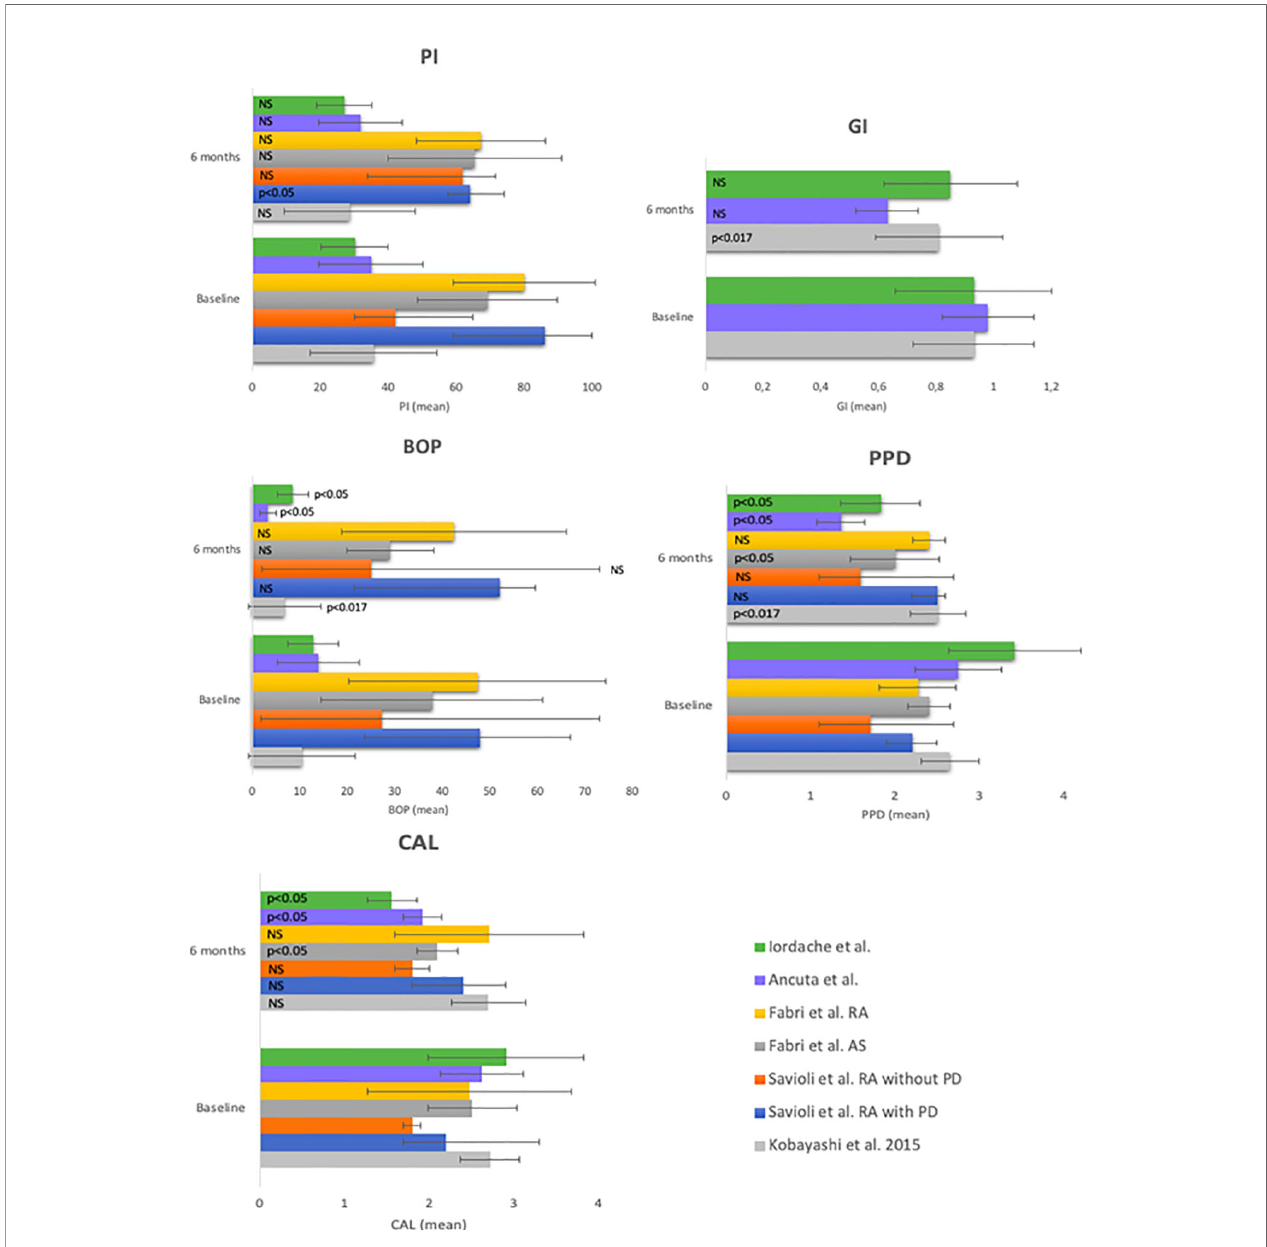
FIGURE 2 | Periodontal parameters at baseline and at 6 months of anti-TNF- a treatment. PI, plaque index; GI, gingival index; BOP, bleeding on probing; PPD, probing pocket depth; CAL, clinical attachment